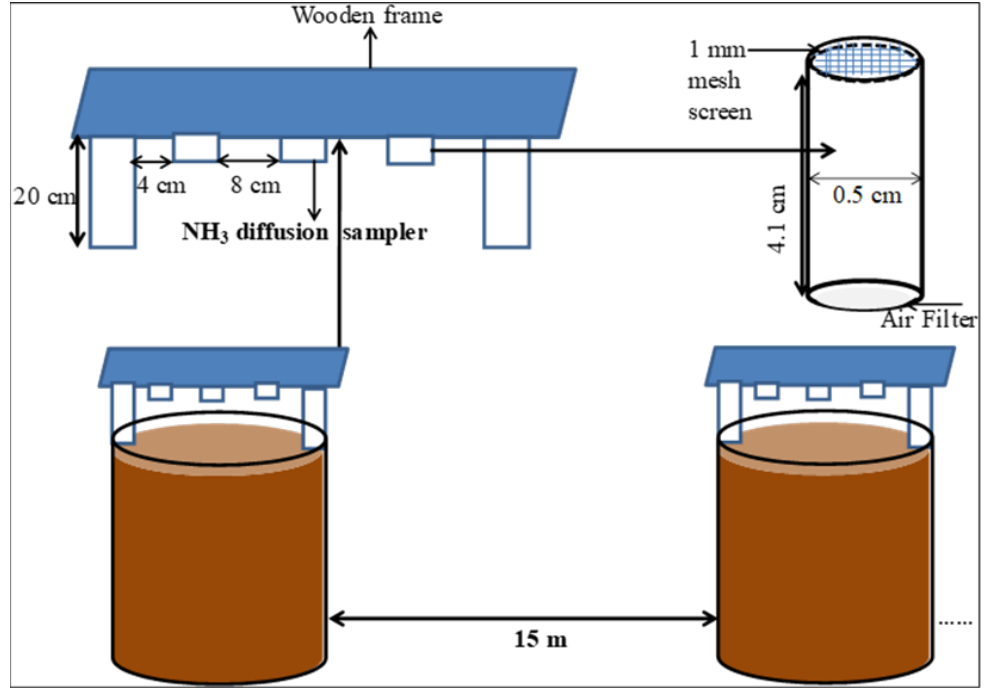
Figure 1. Schematic diagram of ammonia emission (NH 3 ) measurement from the pots. The samplers were installed vertically at height of 20 cm above soil surface in the center of each pot for 72 h. Passive samplers were hanged in a wooden frame facing open side of each sampler downward. A distance of 15 m was kept between two adjacent pots to avoid mixing of NH 3 between the experimental units. The NH 3 was captured by steel grids coated with 60 µ L of sulfuric acid (10% ( w / v )). After 72 h, the samplers